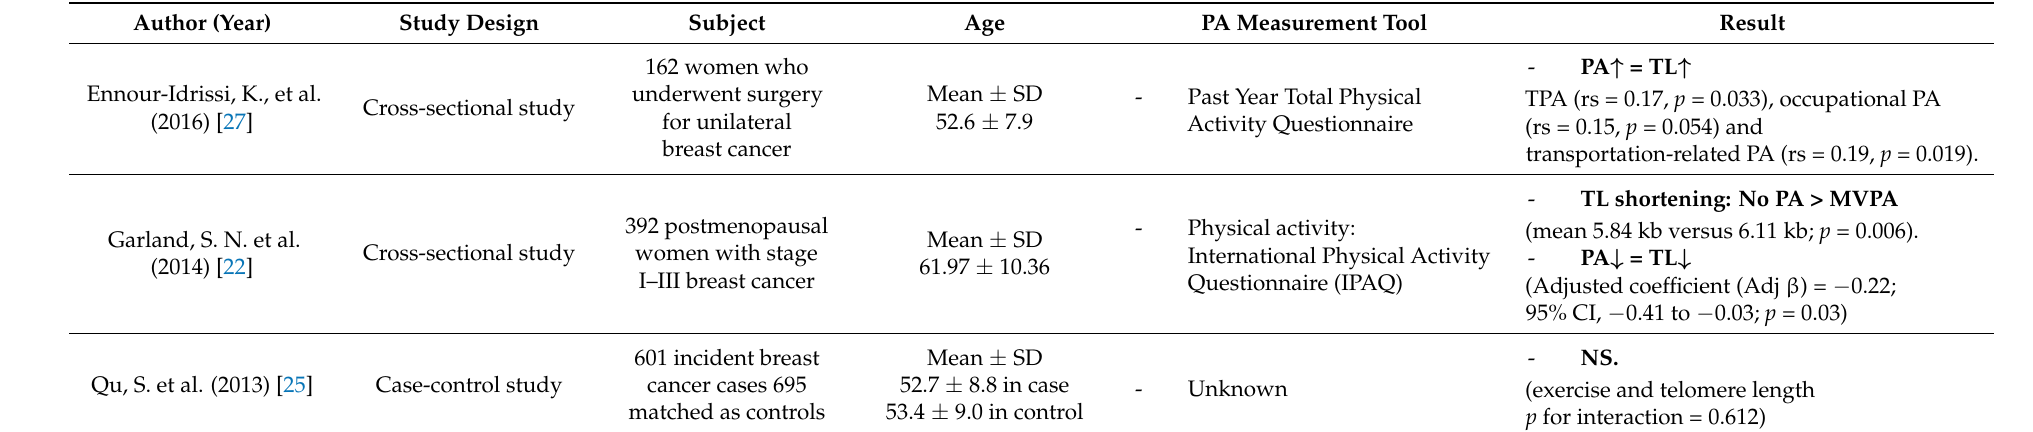
Table 3. The summary of the included non-randomized controlled trials